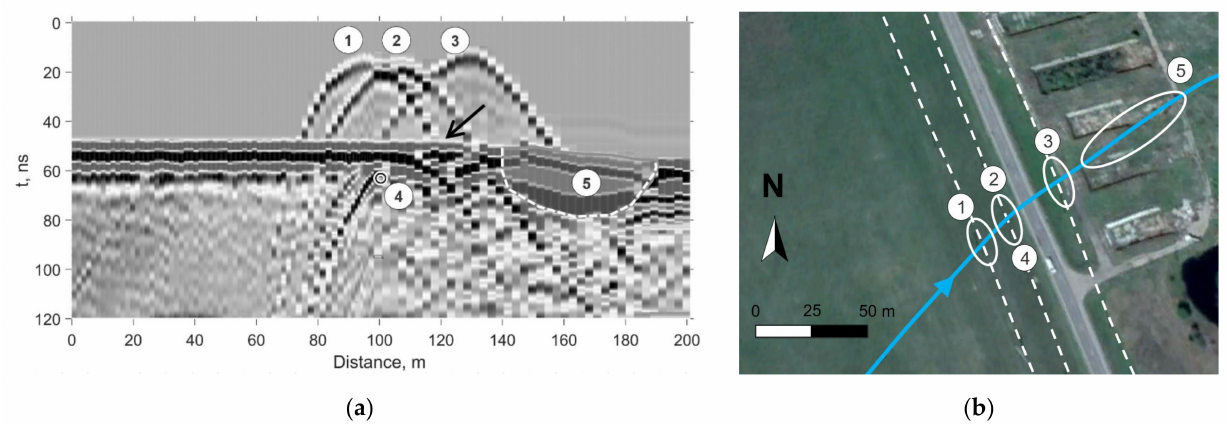
Figure 6. Subsurface probing from a helicopter: ( a )—experimental radargram, B-scan, ( b )—satellite image (Google Earth) of the helicopter flight path, blue line. Characteristic objects: ( 1–3 ) 3 kV electric power lines denoted by dashed white lines; ( 4 ) buried cable; ( 5 ) silage pit; “arrow” shows the road in ( a ).